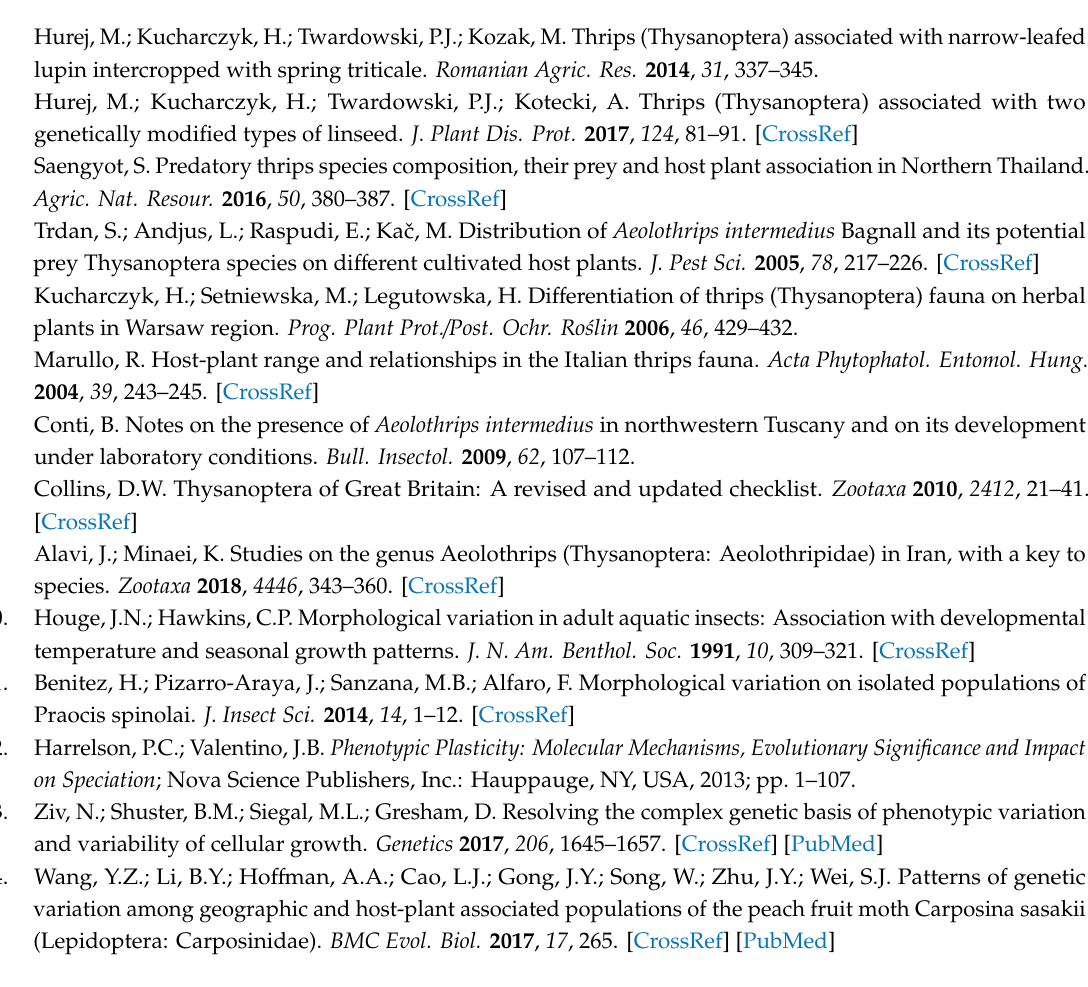
Figure S1: Aeolothrips intermedius males and females-photographic documentation; Table S1: Body measurements of Aeolothrips intermedius in di ff erent crops and localities ( µ